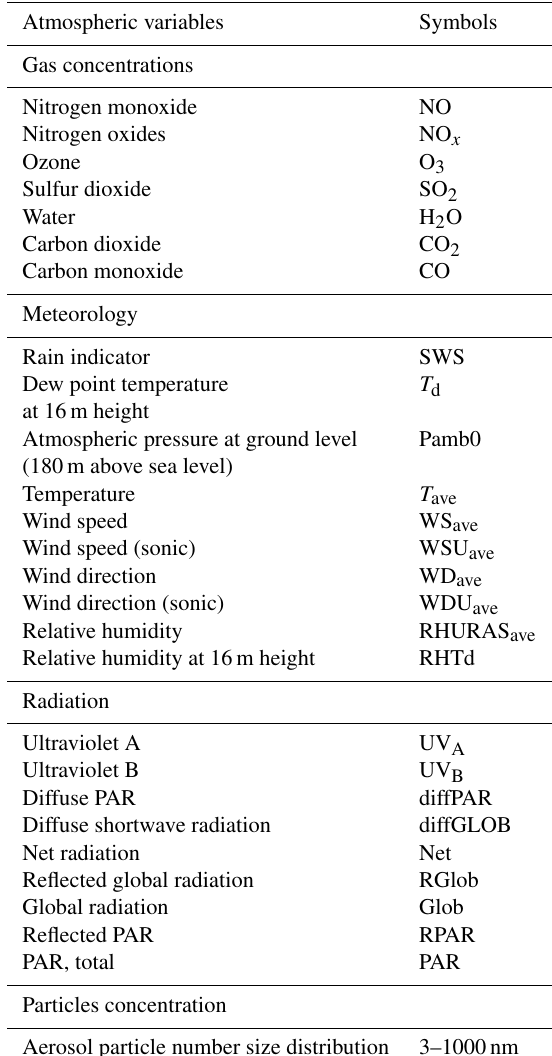
Table 1. The name of used atmospheric variables and symbols dis- played in the results used in this